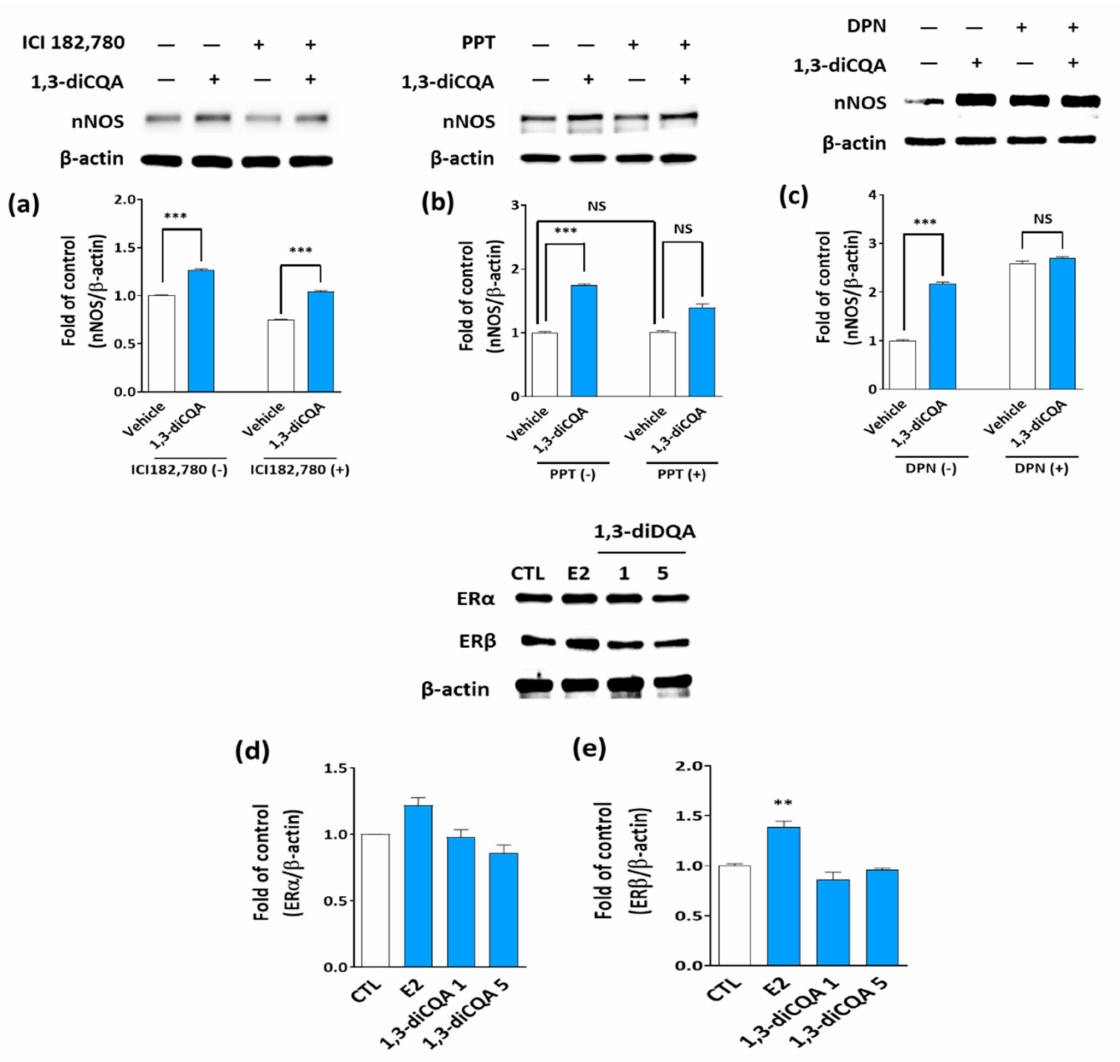
Figure 6. 1,3-diCQA regulates nNOS expression directly rather than indirectly through ERs. Immunoblotting shows nNOS protein levels in the cultured SH-SY5Y cells treated by 5 uM 1,3-diCQA, with or without ( a ) 1 µ M ICI180,720 (a nonselective ERs antagonist), ( b ) 10 µ M PPT, or ( c ) 10 µ M DPN, for 24 h. ( d , e ) 1,3-diCQA treatment did not affect ERs in the primary neuronal cells. Results are presented as mean ± SD. ** p < 0.01, *** p < 0.001 vs. vehicle-only treated cells, NS; not